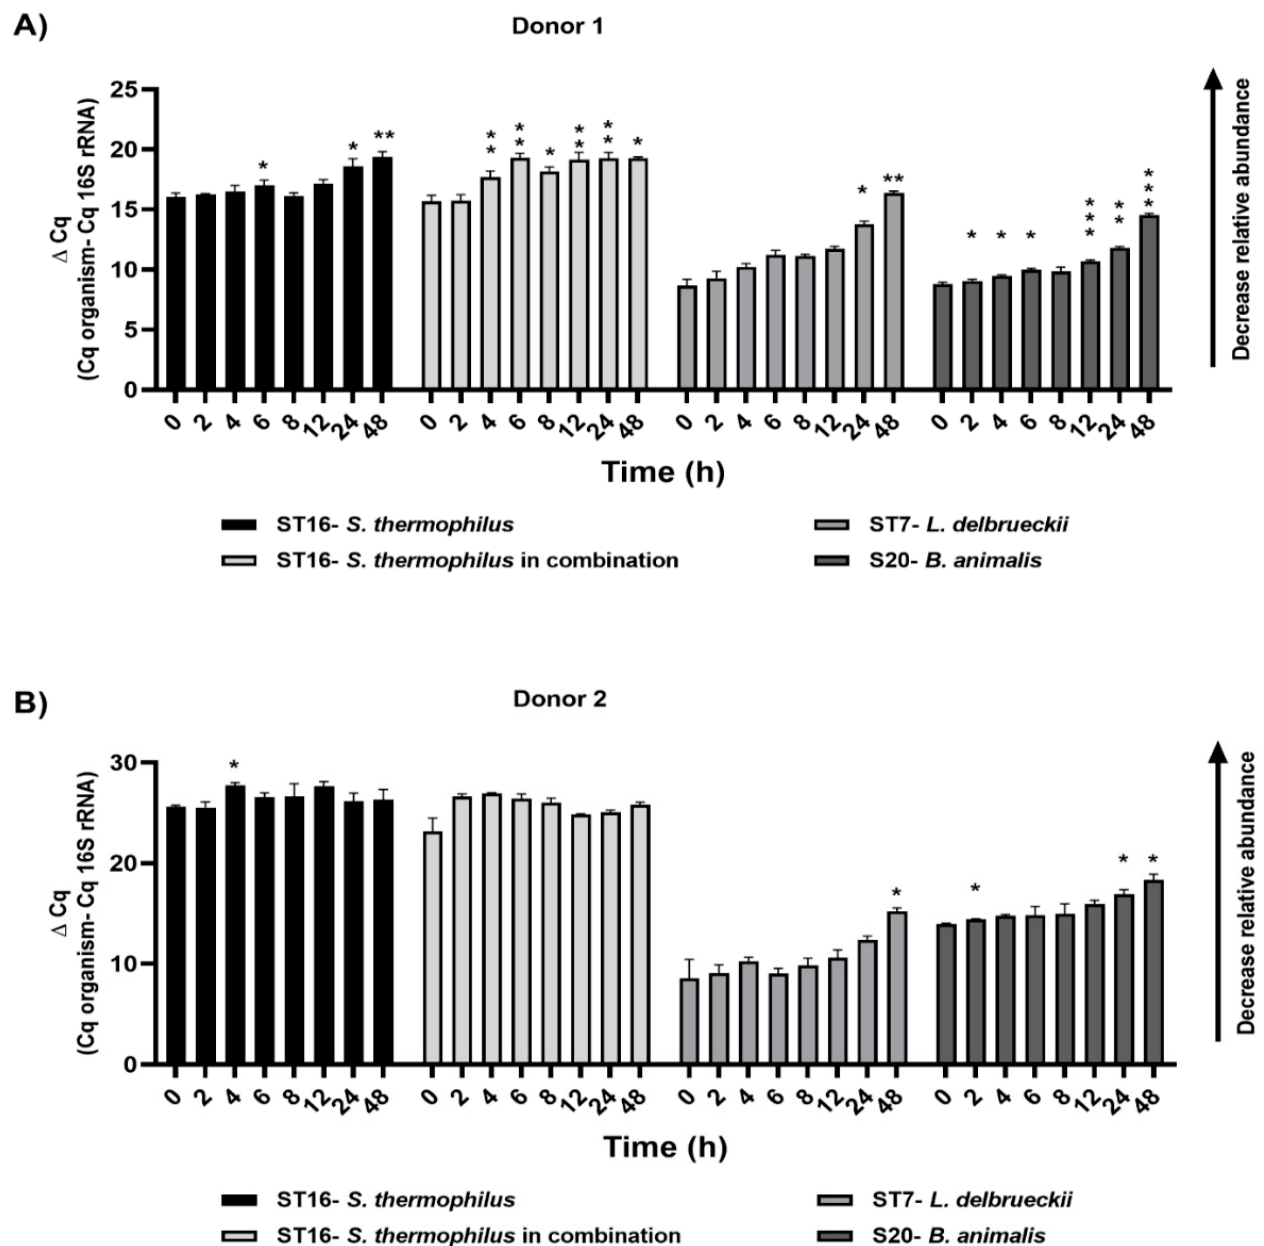
Figure 6. Relative abundance of target species identified by qPCR, as indicated by Δ Cq: relative abundance of inoculated probiotic candidates in various bioreactors with donor 1 ( A ) and donor 2 ( B ) microbiota over 48 h post treatment. The increase in ∆ Cq indicates a decrease in the relative abundance. Repeated measures ANOVA with Dunnett’s multiple comparisons test was used for statistics. Significant differences were indicated for each time point compared to the zero time (* p < 0.05, ** p < 0.01, *** p <0.001).